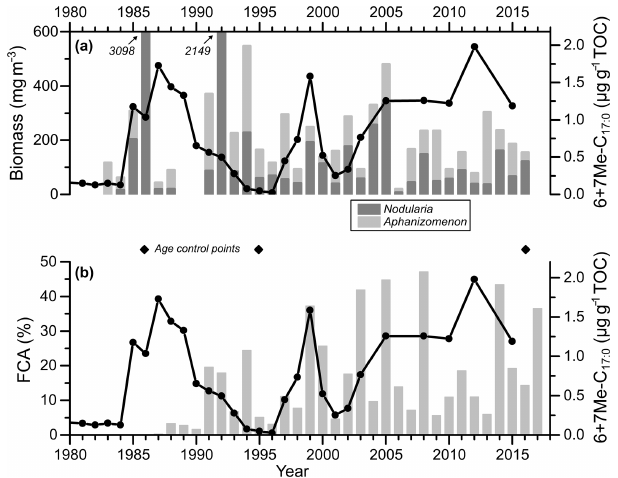
Figure 4. Core MSM51-2/20 record of the sum of 6Me-C 17 : 0 and 7Me-C 17 : 0 (6 + 7Me-C 17 : 0 ) normalized to TOC (line with dots) (a, b) and bar plots of Nodularia spumigena and Aphanizomenon sp. summer (July–August) biomass (a) and the FCA (frequency of cyanobacteria accumulations) index (Kahru et al., 2018) (b) , both for the eastern Gotland Basin (Fig. 1). The diamonds represent the age control points of core MSM51-2/20 (Fig. 2; Table S2). The data are listed in Table S4.